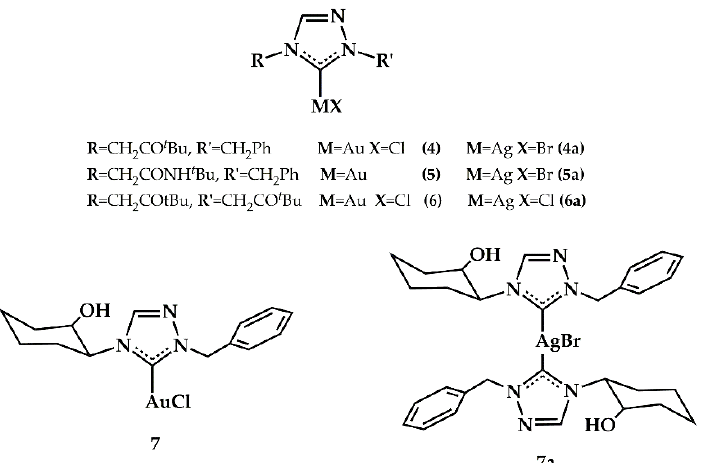
Figure 4. Gold and silver precatalysts of 1,2,4-triazole based NHCs synthesized from Ghosh et al. [17].